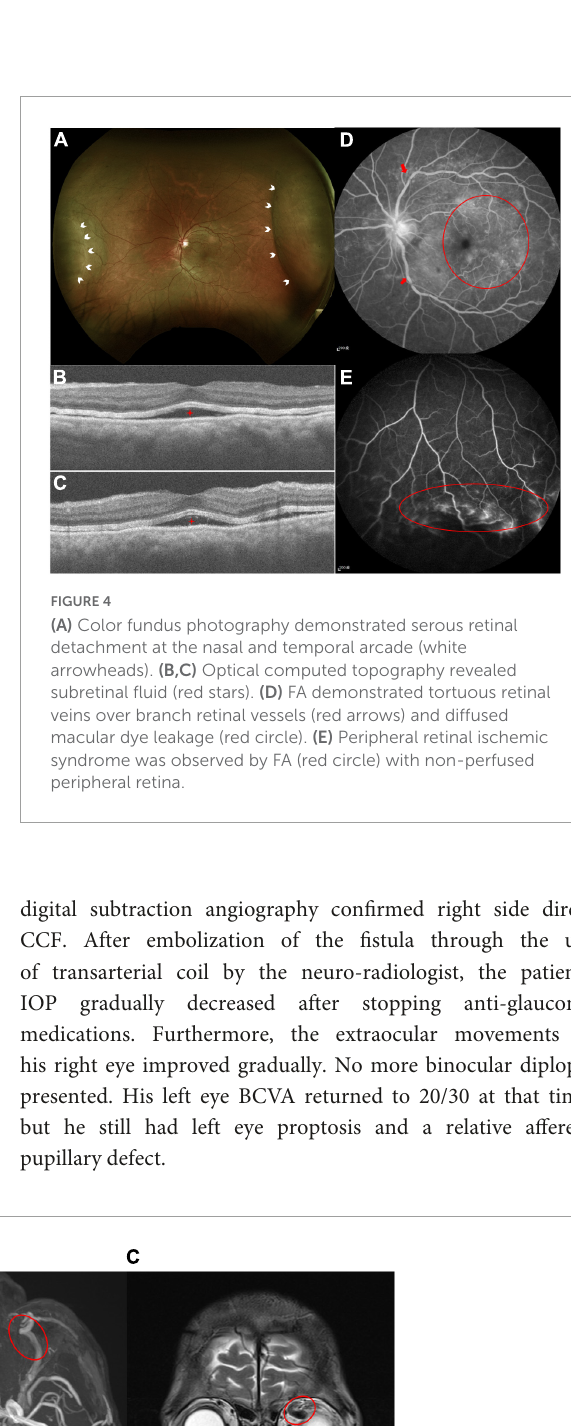
FIGURE3 (A,B) Engorged left superior ophthalmic vein (red circle) in magnetic resonance imaging (A) , magnetic resonance angiography (B) , which confirmed carotid- cavernous sinus fistula. [ (A) T2-weighted-Fluid-Attenuated Inversion Recovery, transverse view; (B) magnetic resonance angiography]. (C) Coronal view of magnetic resonance imaging revealed prominent engorged superior ophthalmic vein (red circle) [T2- Turbo spin echo (TSE) imaging, coronal